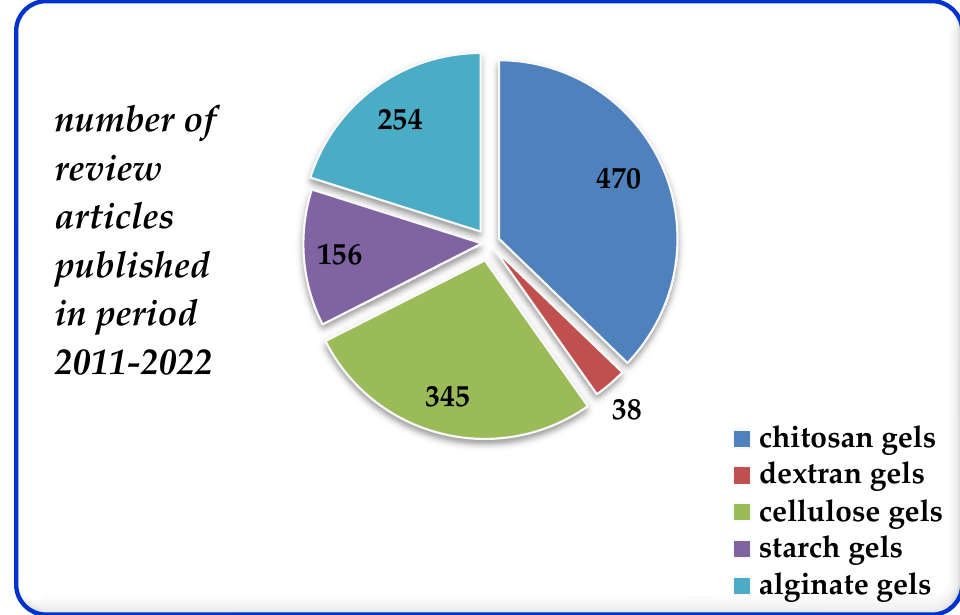
Table 1. Some novel formulations of polysaccharides and other